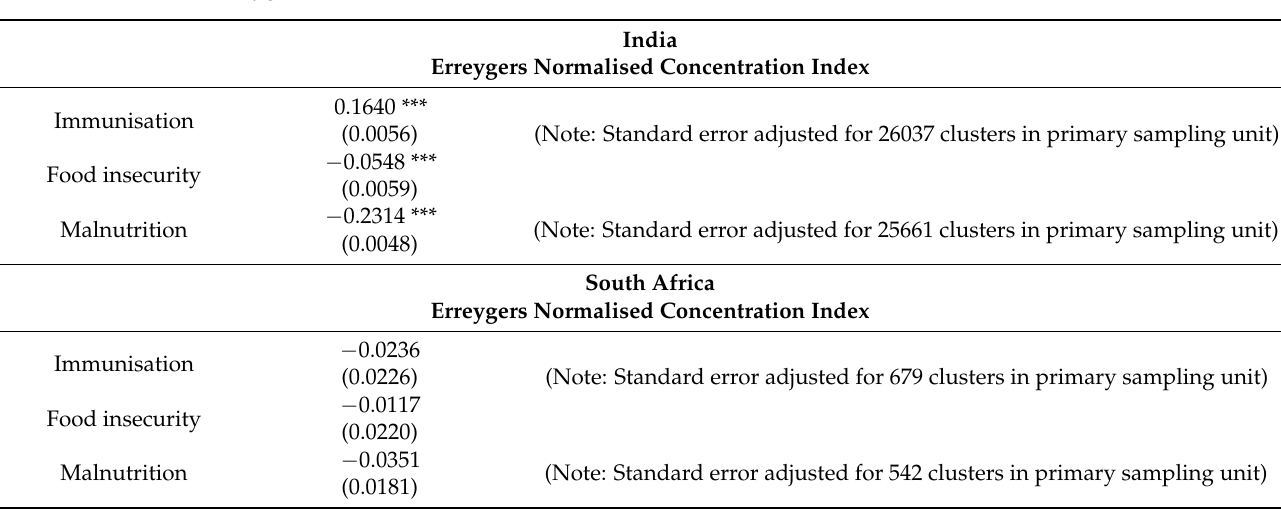
Table 3. Erreygers normalised concentration indices for child health indicators for South Africa and